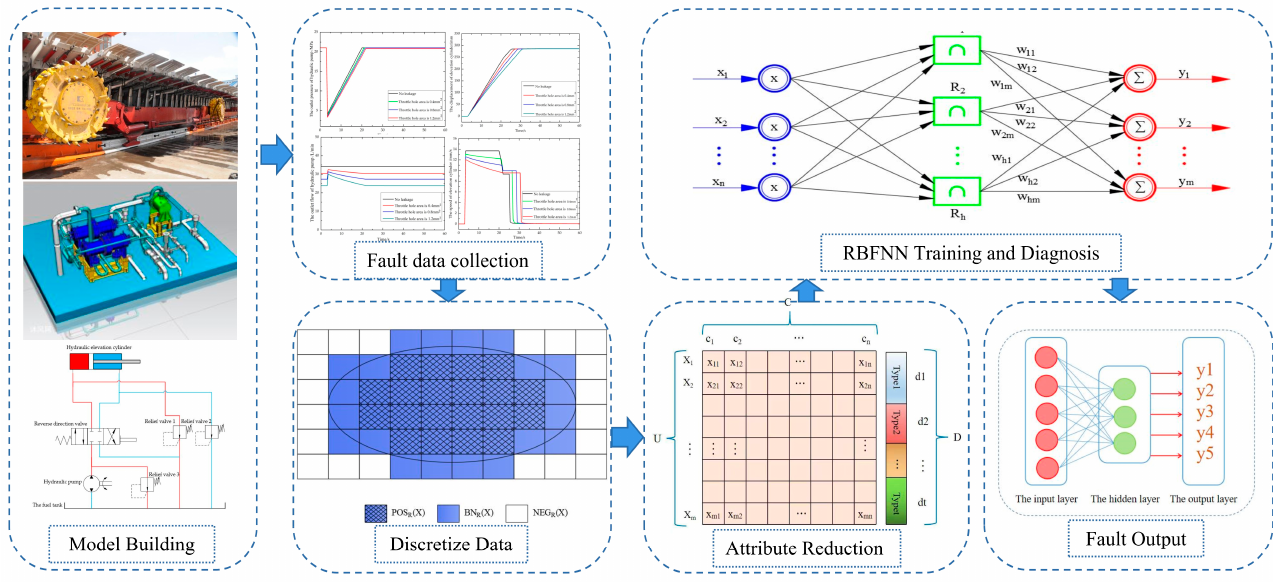
Figure 1. The whole idea of the RS-RBFNN fault diagnosis method.